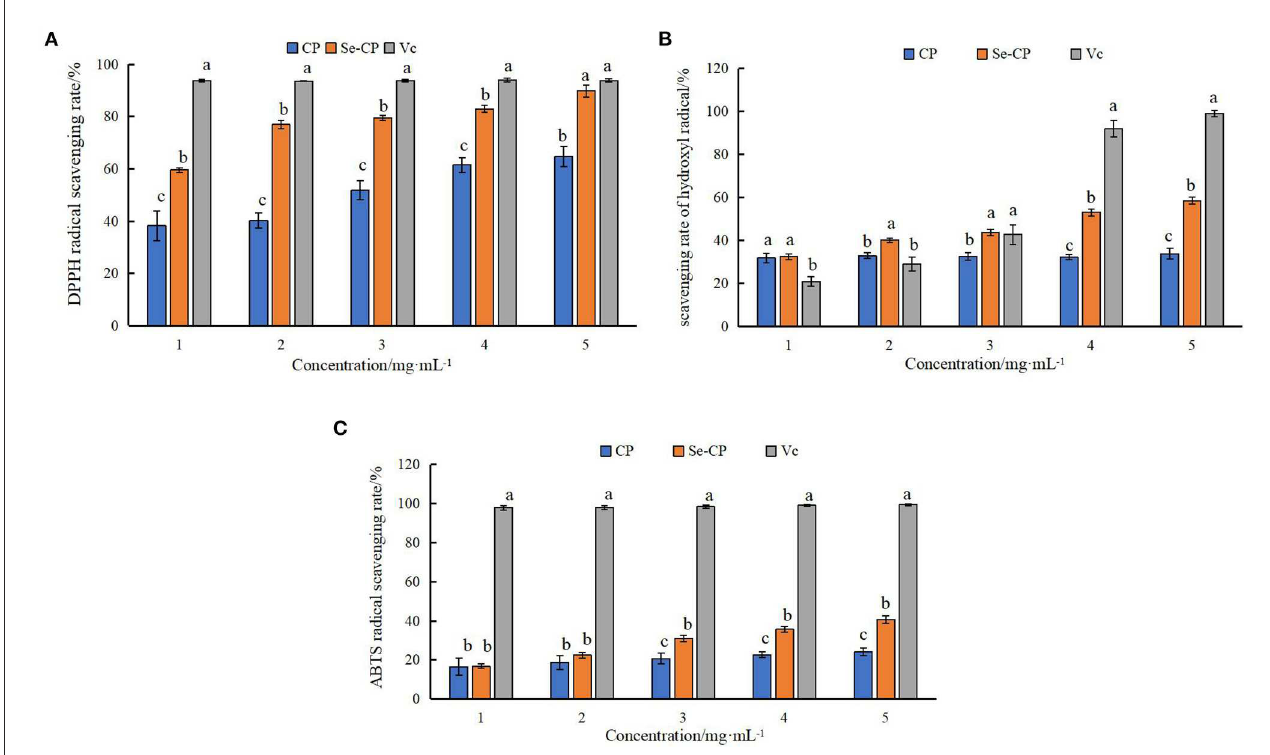
FIGURE14 Antioxidant activity of selenated polysaccharides (A) DPPH radical scavenging activity (B) hydroxyl radical scavenging activity (C) ABTS radical scavenging activity.